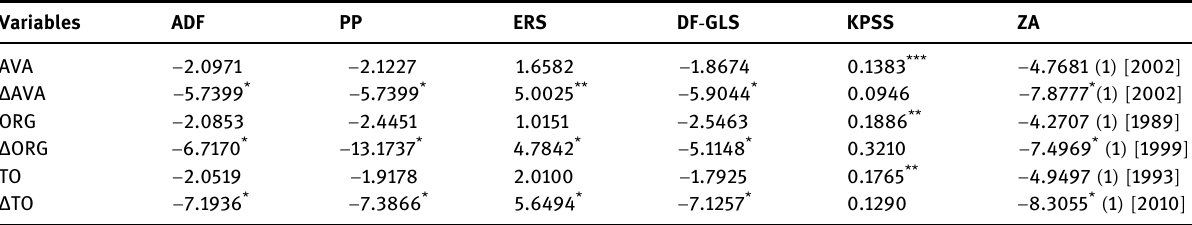
Table 3: Unit root tests